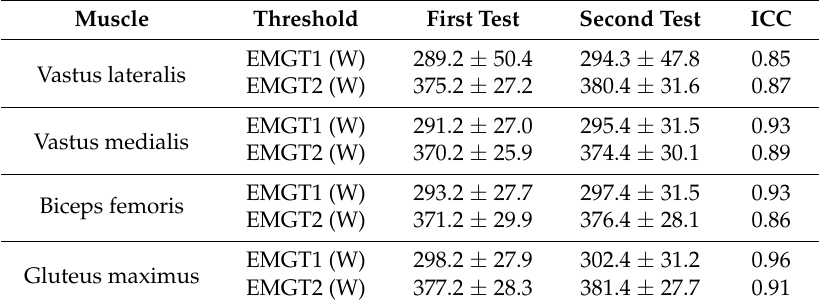
Table 5. Reliability of measurements of the electromyographic thresholds EMGT1 and